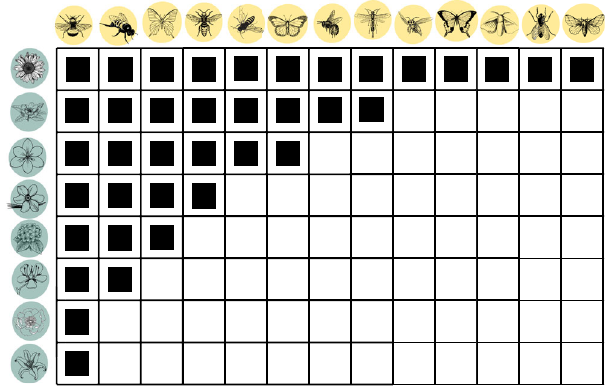
FIG. 1. Example of a perfectly nested biadjacency matrix for a bipartite plant-pollinator network. Each node represents a differ- ent species, and black boxes represent a mutualistic interaction between a plant and a pollinator. It can be observed that the interactions of any species form part of a subset of the interactions of all species with larger